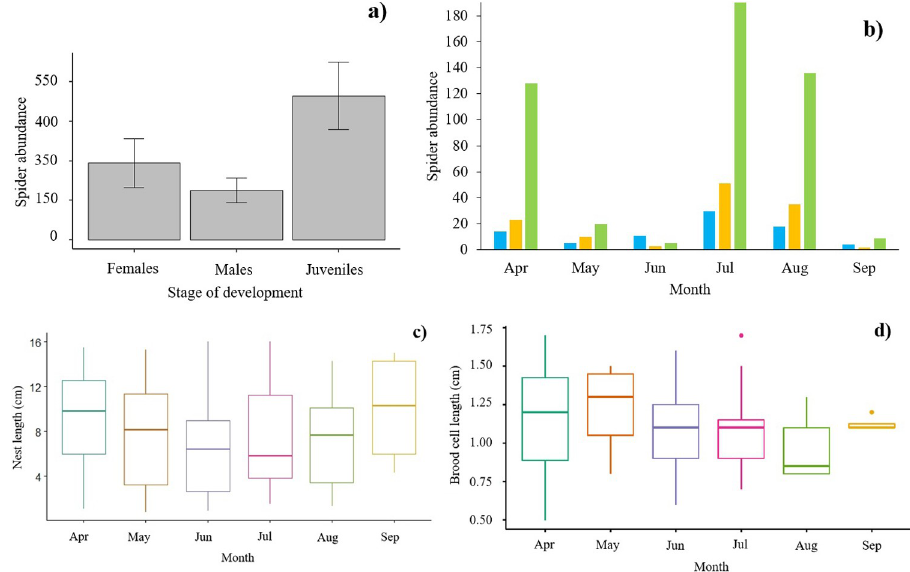
Fig 3. Spiders captured by the Trypoxylon wasps throughout the localities. a) Life cycle stage of captured spiders; abundance was counted as adults (male, female) and juvenile individuals; b) monthly variation of total spider abundance c) nest length and d) cell length. Whiskers represent the standard error. Blue bars = males, orange = females, green =